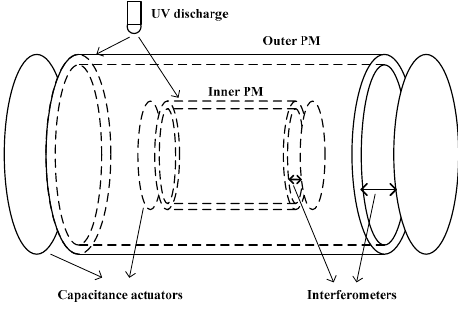
Figure 4. Schematic of PMs of TEPO.